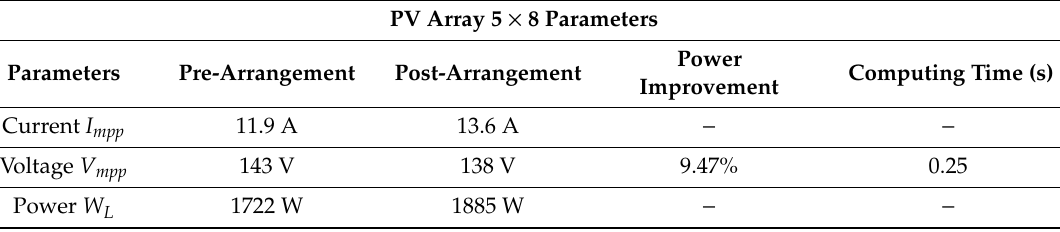
Table 6. PV array 5 × 8 parameters Pre and